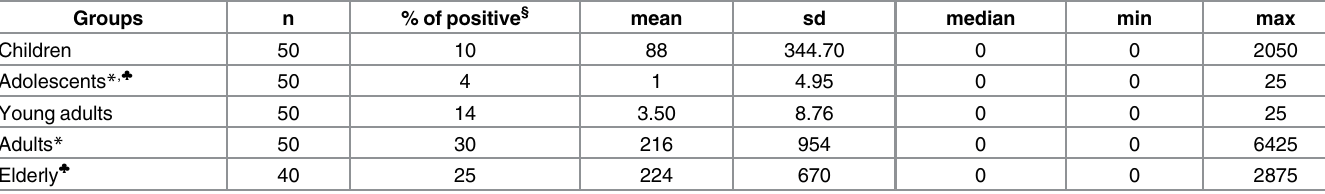
Table 1. Oral carriage of enterococci in different age-related cohorts (expressed as colony-forming units per milliliter; cfu/mL). Groups